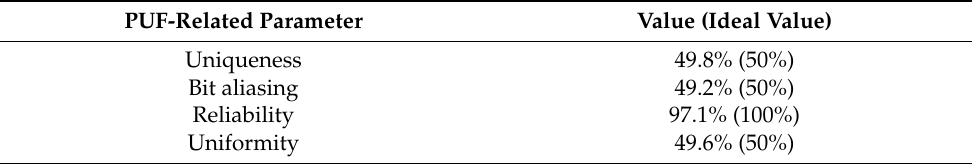
Table 2. PUF-related parameters of interest. Their values and ideal values are